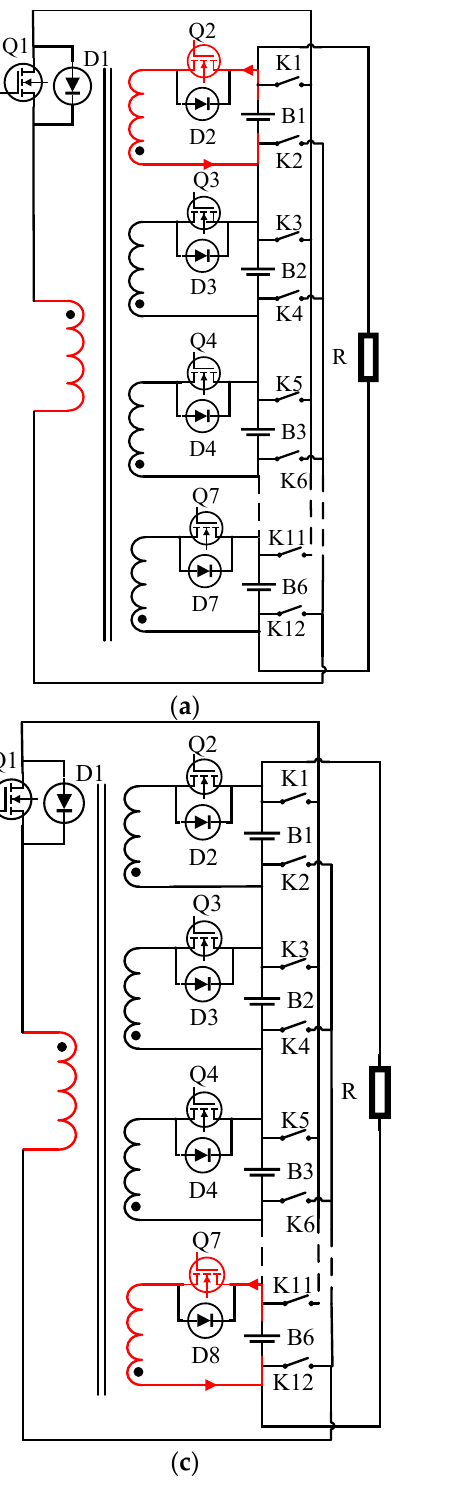
Figure 6. Working process of equalization mode 3. ( a ) Battery B1 discharges to primary wind- ing. ( b ) Primary winding discharges to battery B2. ( c ) Battery B6 discharges to primary winding. ( d ) Primary winding discharges to